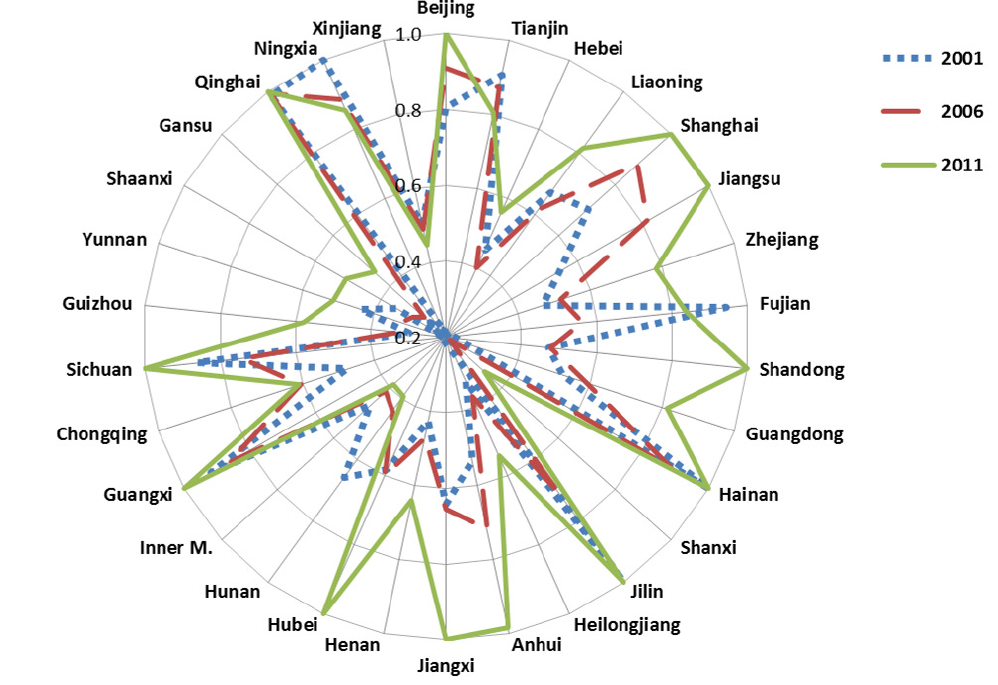
Figure 2. Provincial level energy efficiency in 2001, 2006 and